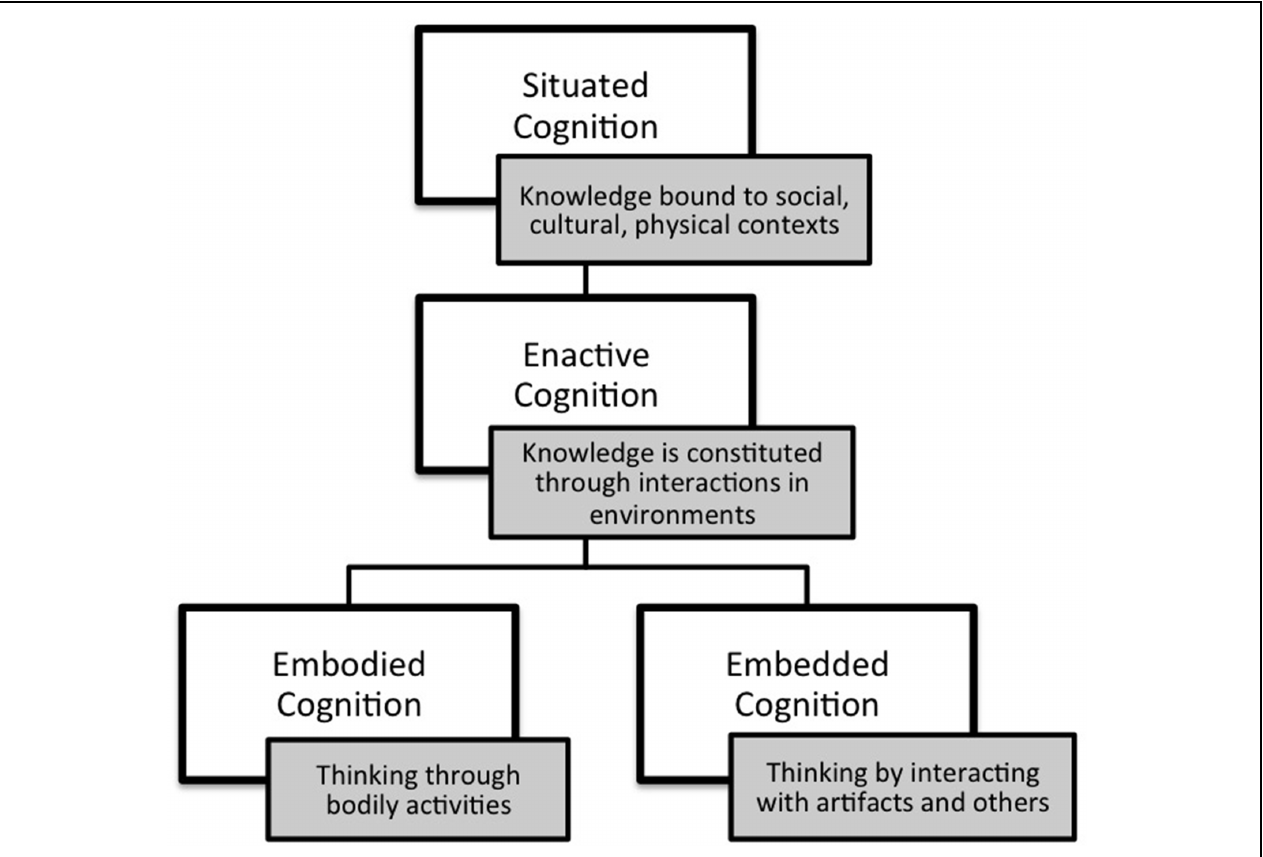
FIGURE 1 | Situated cognition and the three